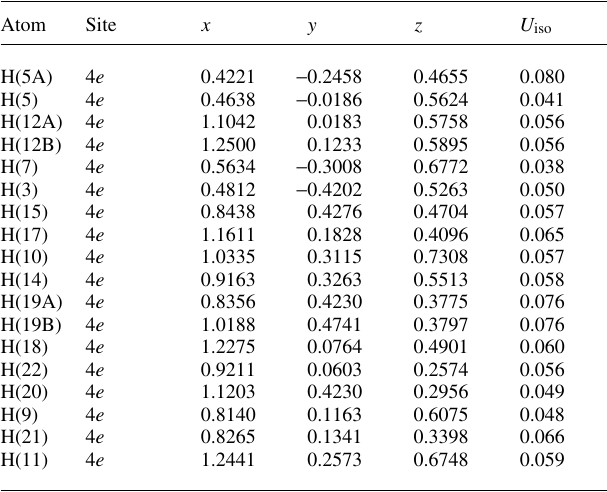
Table 2. Atomic coordinates and displacement parameters (in Å 2 )